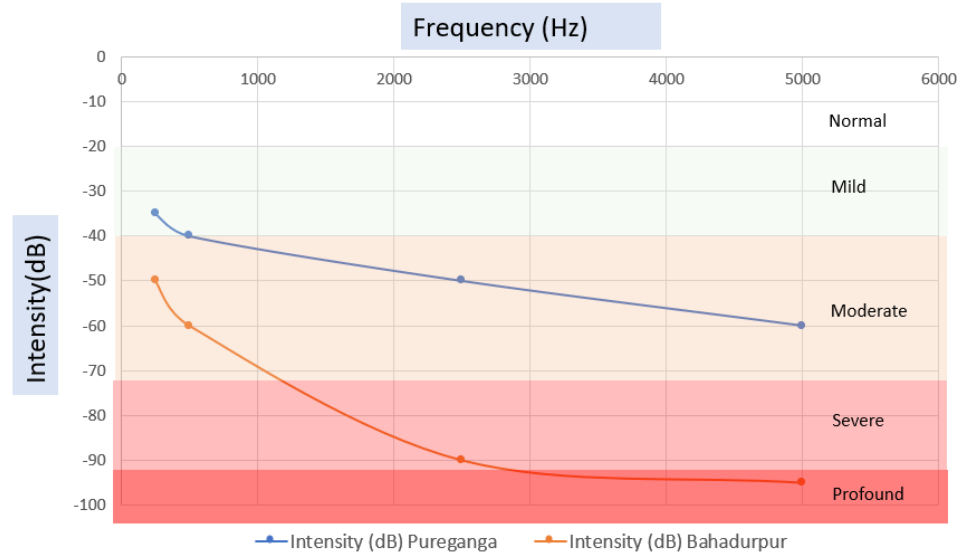
Figure 25. Audiogram of the surveyed population at the Bahadurpur and Pure Ganga Figure 25 Audiogram of the surveyed population at the Bahadurpur and Pure Ganga intersections.